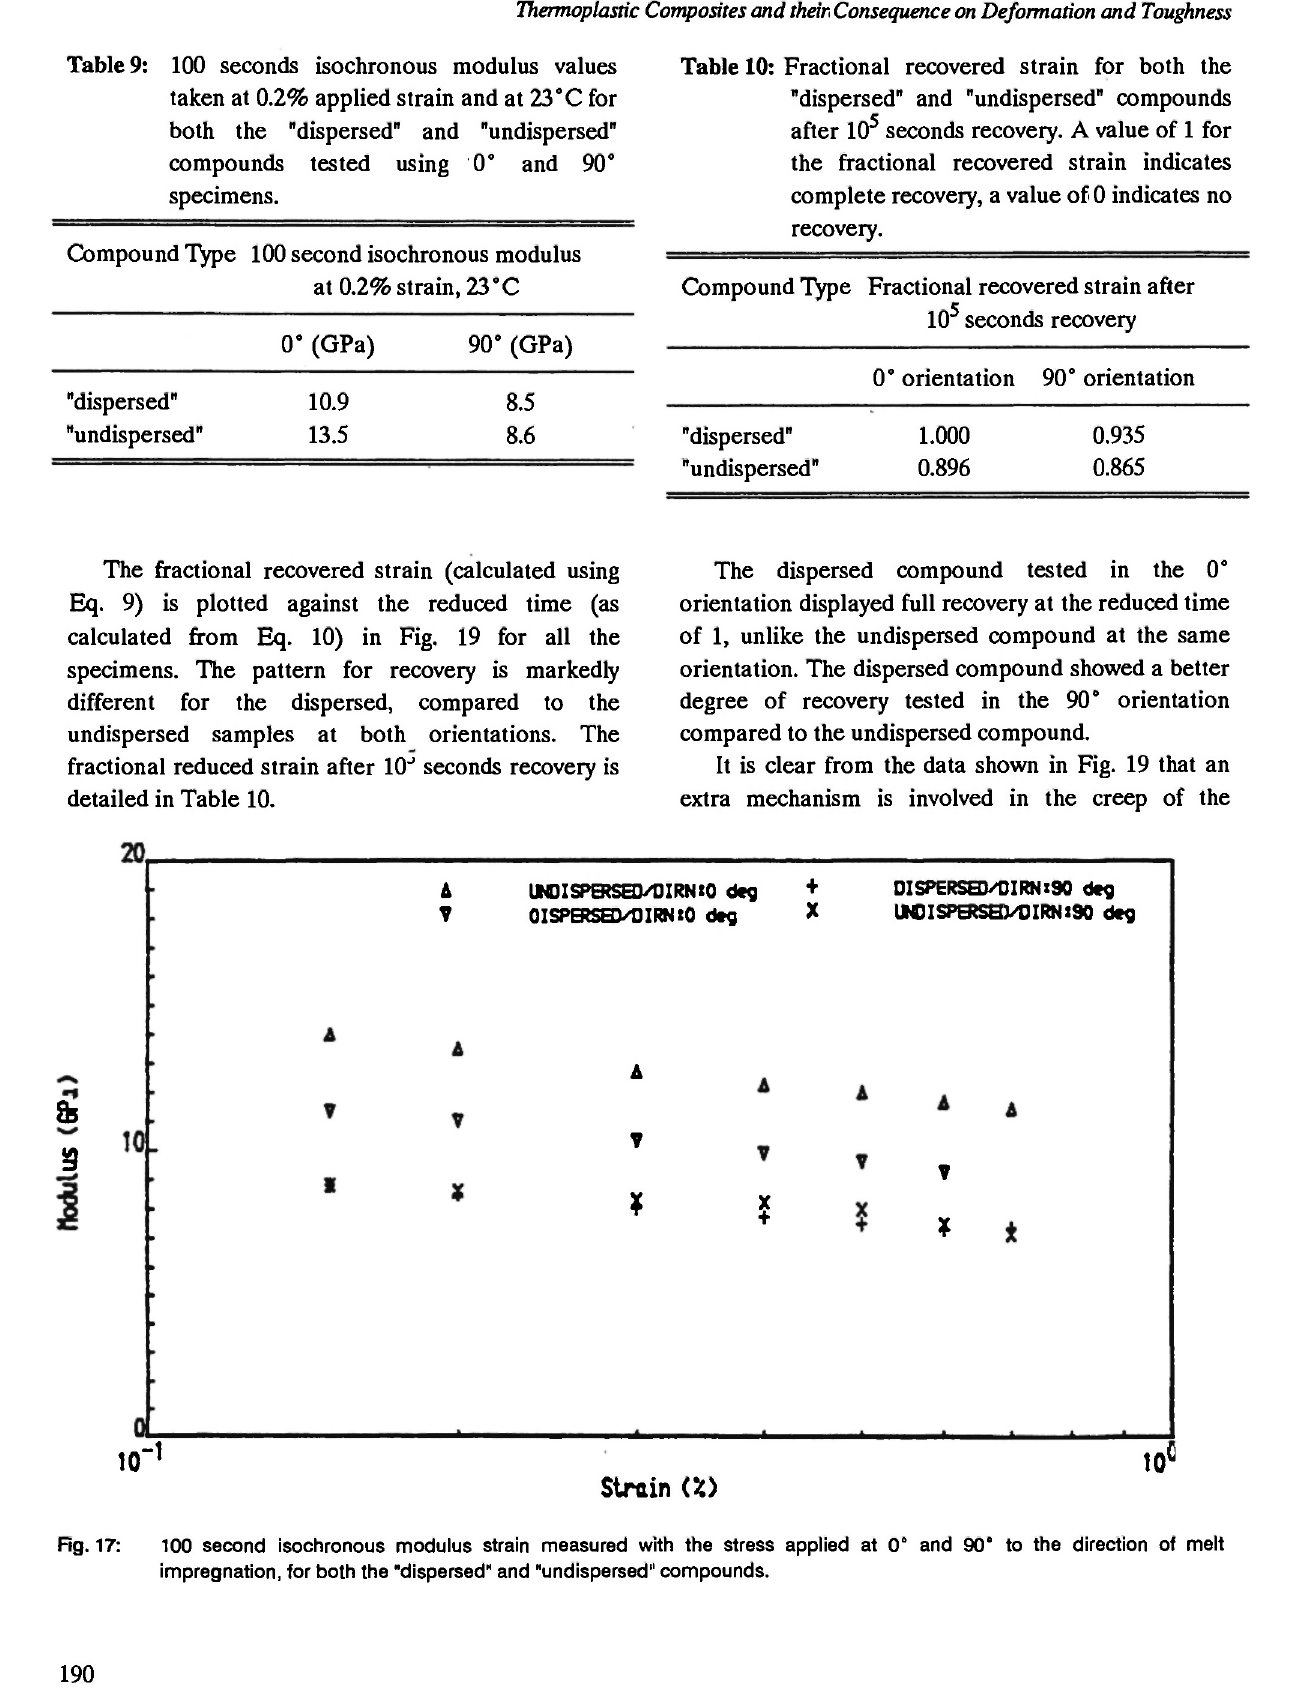
Table 10: Fractional recovered strain for both the "dispersed" and "undispersed" compounds after 10 5 seconds recovery. A value of 1 for the fractional recovered strain indicates complete recovery, a value of 0 indicates no recovery.